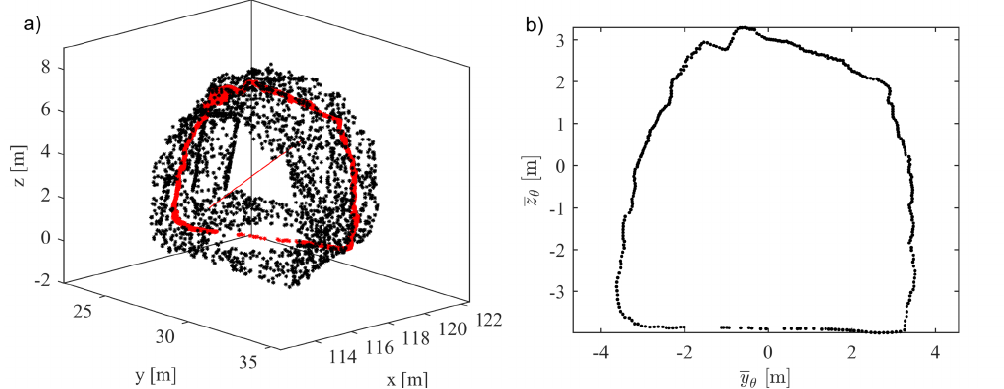
Figure 3. ( a ) depicts a section of the tunnel. The black points represent the point-cloud, the red points are all points within 0.10 m of the perpendicular plane, the red line is the centreline of the tunnel. ( b ) depicts the cross section resulting from averaging the red points in ( a